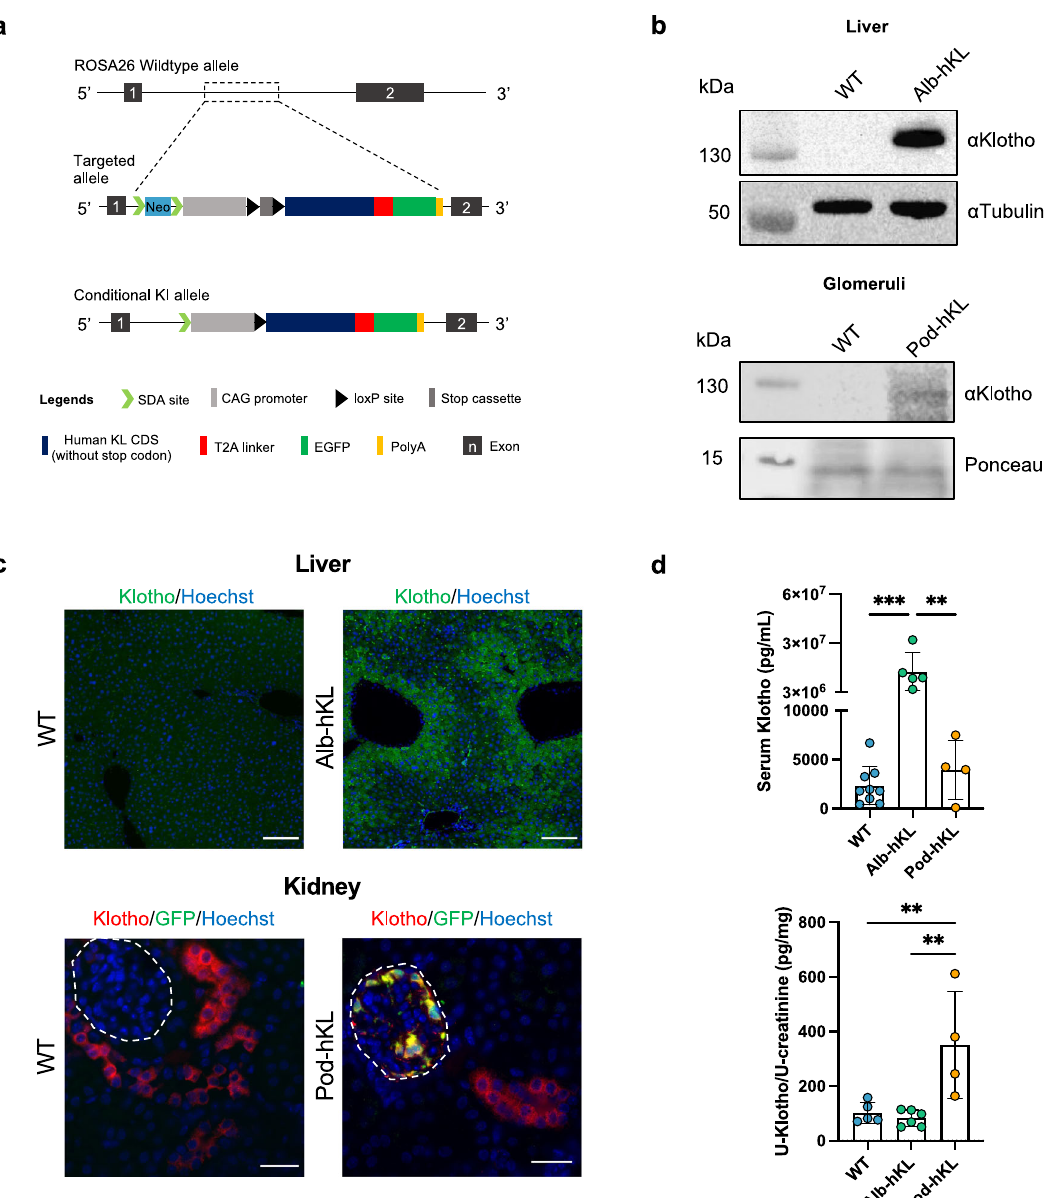
Fig. 3 Generation of conditional full-length human Klotho knock-in allele and targeted insertion of human Klotho in Alb-hKL and Pod-hKL mice. a Schematic representation of ROSA26 wild-type allele (top), targeted allele (middle), and conditional knock-in allele (bottom). In the latter, full-length human Klotho expression is speci fi cally induced in hepatocytes or podocytes by using Cre – LoxP recombination system. Albumin- or podocin-cre mice were crossed with mice expressing the targeting vector, containing a lox-STOP-lox cassette between the splice acceptor sites and Klotho cDNA under the CAG promoter, that was introduced into the ROSA26 locus. b Western blotting of whole liver extracts from WT and Alb-hKL (top) and glomeruli-enriched lysates from WT and Pod-hKL mice (bottom). c Representative immuno fl uorescent stainings of Klotho and GFP in liver (top) and kidney (bottom) of Alb- hKL and Pod-hKL, respectively. d Serum (top) and urine (bottom) Klotho levels in WT ( n = 9), Alb-hKL ( n = 5), and Pod-hKL ( n = 4) mice. ** p < 0.01; *** p < 0.001. Scale bars: 100 μ m, 30 μ m ( c ). Statistical signi fi cance between groups was determined using one-way ANOVA followed by multiple